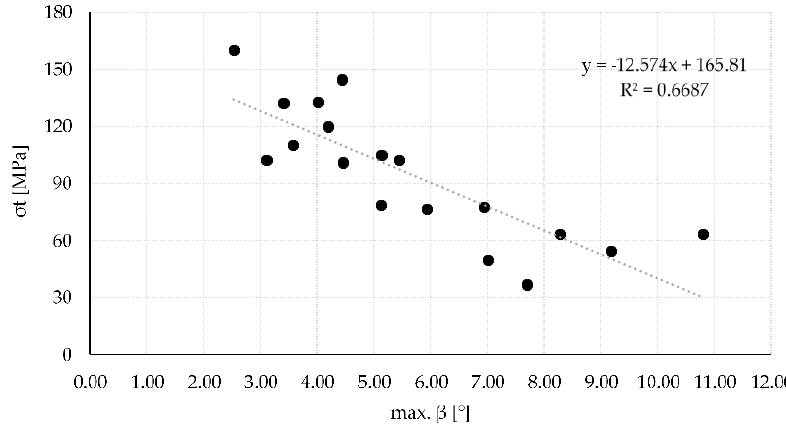
Figure A2. Influence of maximum β on the tensile strength of n = 18 samples (r = -0.818).